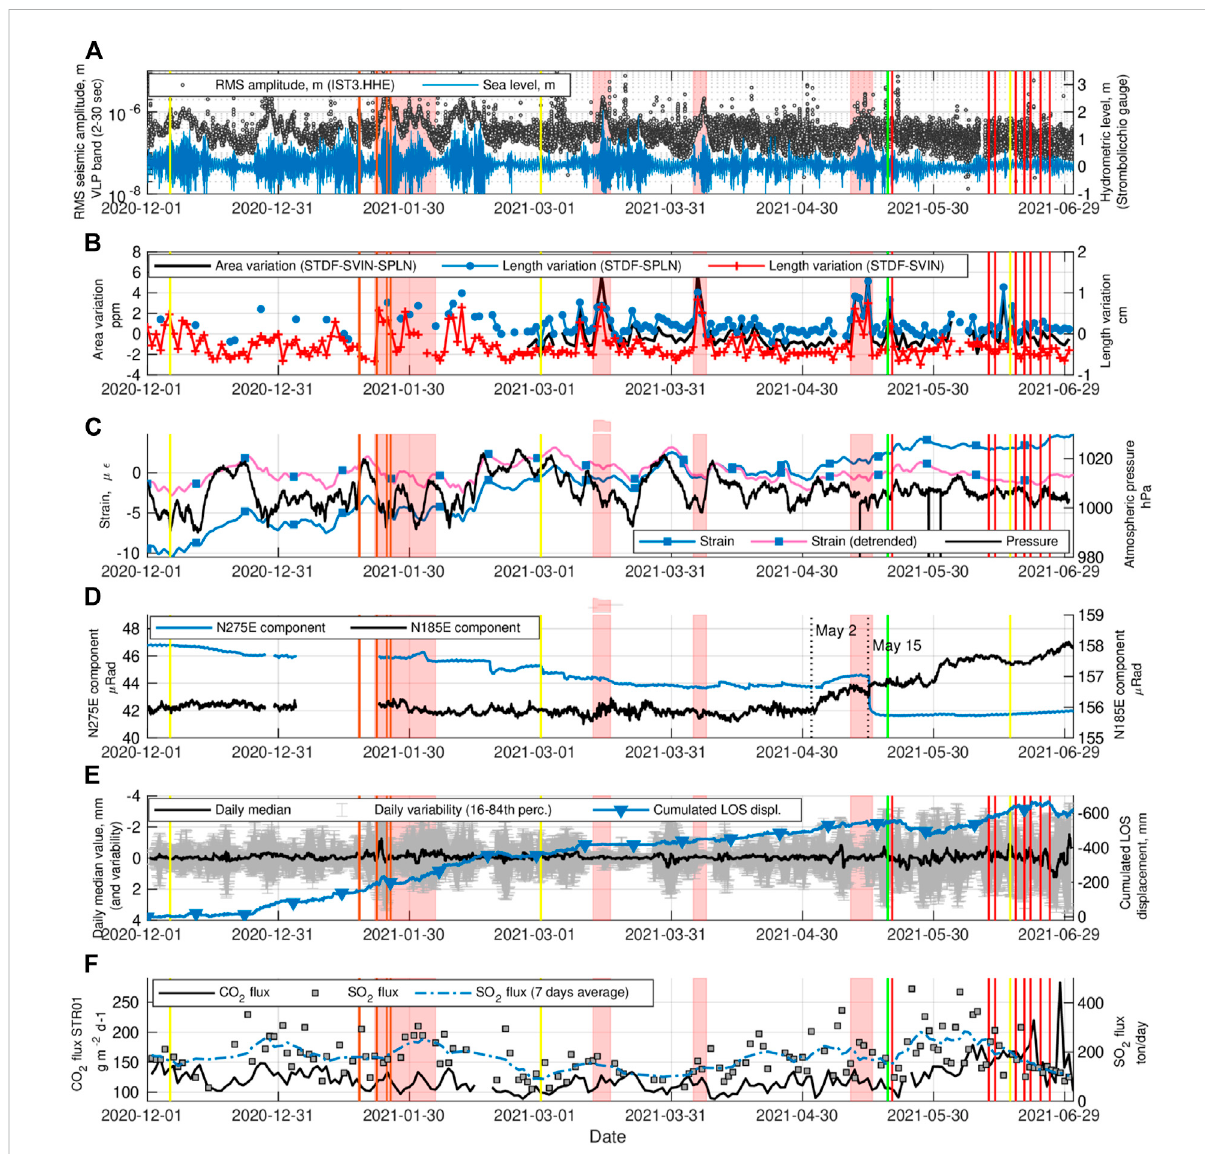
FIGURE 10 (A) RMS amplitude measured in the IST3 very broadband seismic station in the frequency band from 2 to 30 s (which includes the typical frequenciesofVLPeventsatStromboli).ThebluelineshowstheseahydrometriclevelmeasuredatStrombolicchiogauge(sealeveldatafromISPRA). (B) Variation ofthearearecordedatthetriangleSTDF-SVIN-SPLN(black line)andvariation ofthebaseline betweentheSTDF-SPLN (bluepoints) and STDF-SVIN (red points) stations. The pink rectangles indicate short phases characterized by areal dilatation. (C) Raw and linear detrended strain (blue and red lines) and barometric pressure (black line) time series recorded at SVO station. (D) The two tilt components recorded at Timpone del Fuoco. From the beginning of May ( fi rst black dotted line) a change in the long-term trend is visible. The 15 May sharp variation is also evidenced by theblackdottedline. (E) GBInSARdisplacementtimeseries:thebluelinerepresentsthecumulativedisplacementmeasuredalongtheLOS;theblack line represents the median (50th percentile) of the measures in a moving window of 24 h length, with a sampling step of 1 h; the Gy bars are the valuesofthe16thand84thpercentiles.In (F) thedailyand7-daysaveragebulkSO 2 fl uxemittedfromthesummitcratersofStromboli(bluecurveand graybluesquares,respectively)and theCO 2 fl uxfrom thesoil atScari area, STR01 station(black curve)are displayed.The vertical barsindicate major explosions (yellow); lava fl ows (red); spattering and over fl ows (orange) and fl ank failure and PDC